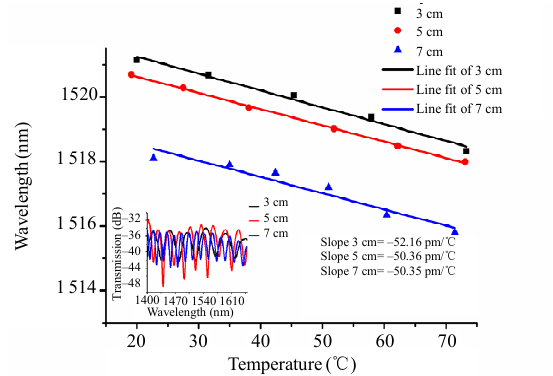
Fig. 5 Transmission spectrum based on the structure with different lengths of the FMF and measured temperature sensitivity.